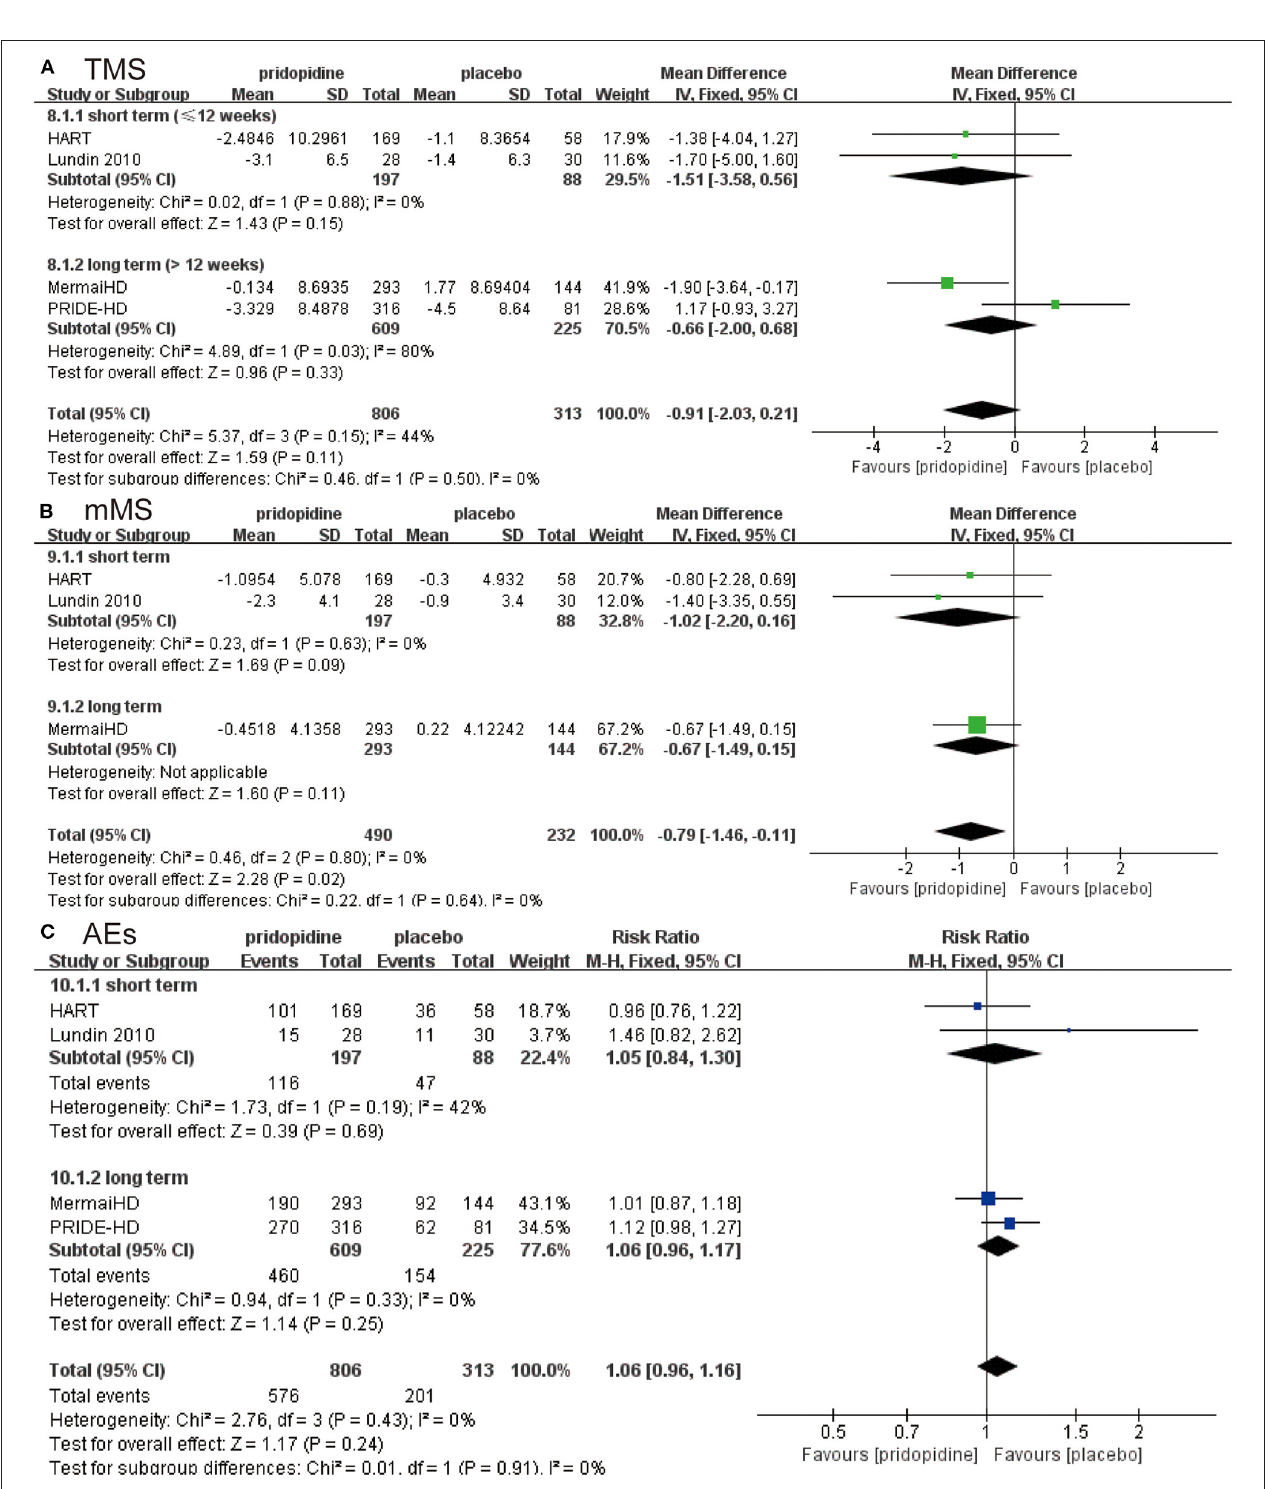
FIGURE 3 | Subgroup analysis of different treatment periods ( ≤ 12 weeks/ > 12 weeks) on efficacy and safety outcomes. The blue diamond indicates the estimated risk ratio (95% confidence interval), and the green diamond indicates the mean difference (95% confidence interval) for all patients together. (A) TMS. (B) mMS. (C) adverse